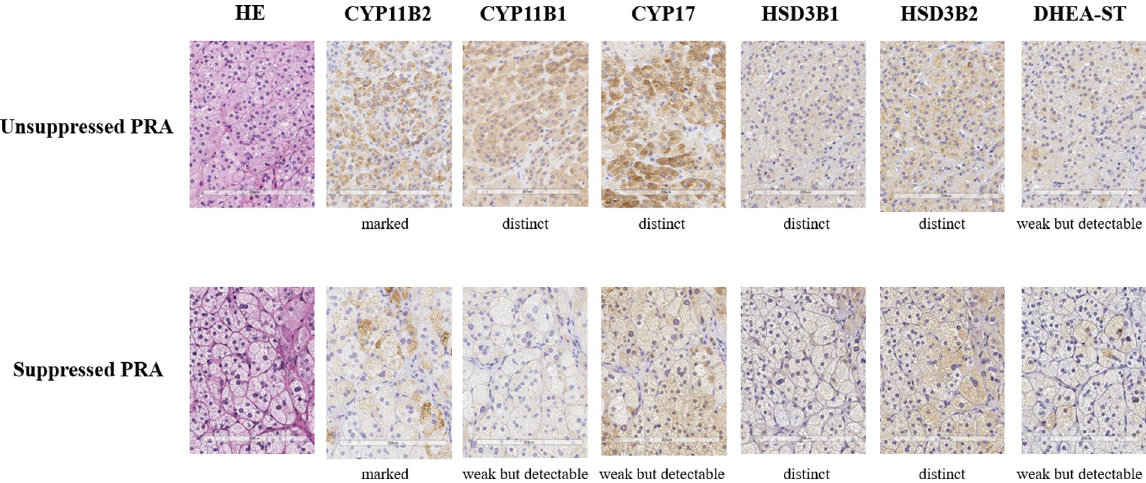
Fig 1. Representative histological images of aldosterone-producing adenomas with unsuppressed and suppressed PRA. HE, hematoxylin and eosin; CYP11B1, 11 β -hydroxylase cytochrome P450; CYP11B2, aldosterone synthase cytochrome P450; CYP17, 17alpha-hydroxylase; HSD3B1, 3- β hydroxysteroid dehydrogenase-isomerase 1; HSD3B2, 3- β hydroxysteroid dehydrogenase-isomerase 2; DHEA-ST, dehydroepiandrosterone sulfotransferase. Immunoreactivity of CYP17 was more abundant in the unsuppressed PRA group. CYP11B2 immunoreactivity was strongly detected, and CYP11B1 immunoreactivity was distinctly detected in both groups. Scale bar: 200 μ m. https://doi.org/10.1371/journal.pone.0267732.g001 summarized in Table 4. Cortical atrophy of the attached normal cortex was not detected in the